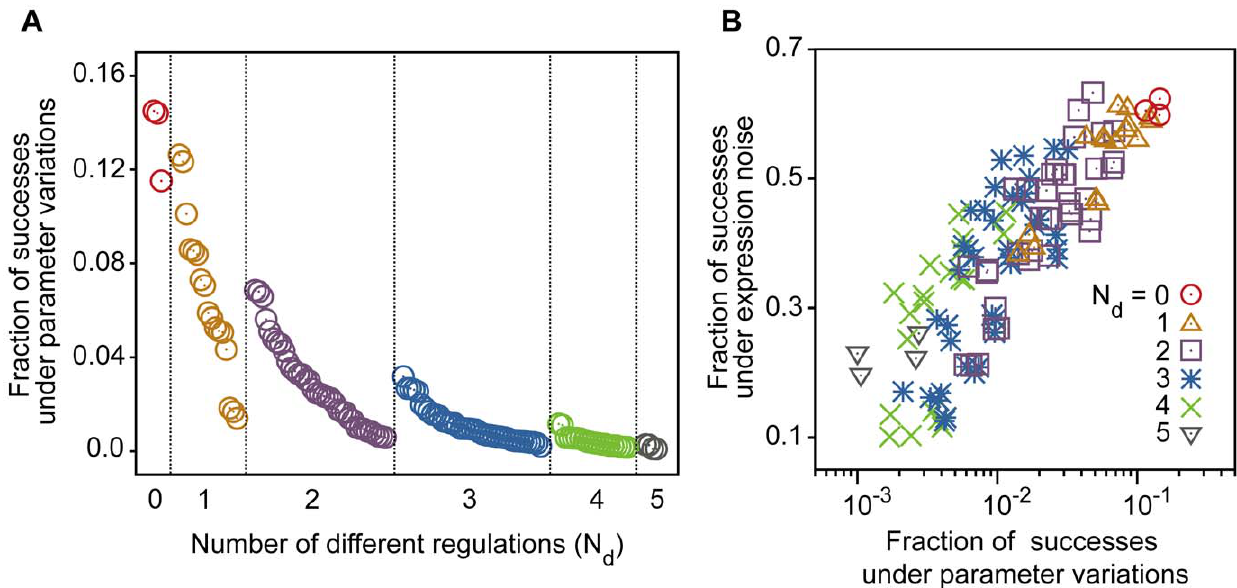
Figure 5. Robustness of the gene expression profiles in the functional networks. ( A ) The fraction of trials that reproduce the experimental expression profile against random assignments of parameters. The values of ~ JJ ij (cid:6) (cid:7) , S i f g , and t x , off are randomly chosen within the ranges shown in Table 4. The other fixed parameter values are also listed in Table 4. Neglecting the positive self-feedback regulations in the 384 functional networks, 120 networks were chosen and investigated ( Materials and Methods ). The dynamics were checked for 50,000 trials in each network. The networks were sorted based on the distance from the Drosophila network (N d ). Here N d corresponds to the number of regulations different from the Drosophila network. Because there are a few possible regulations from the unknown factor x , more than one network with N d =0 exist. ( B ) The fractions of the trials that reproduce the experimental profile under expression noise (vertical axis) are plotted against the fraction of successes against the random parameter assignments. To analyze the stability against noise, we used 1000 different parameter sets, by which the expression profile is reproduced in the absence of noise for each network. The dynamics were checked for 50 trials for each parameter set. doi:10.1371/journal.pcbi.1000760.g005 regulations of only known factors also reproduce the WT Minimum network for the sequential expression An effective way to capture network function is to focus on the specific substructures (network motifs or modules) [1,13,14,16,39,47].